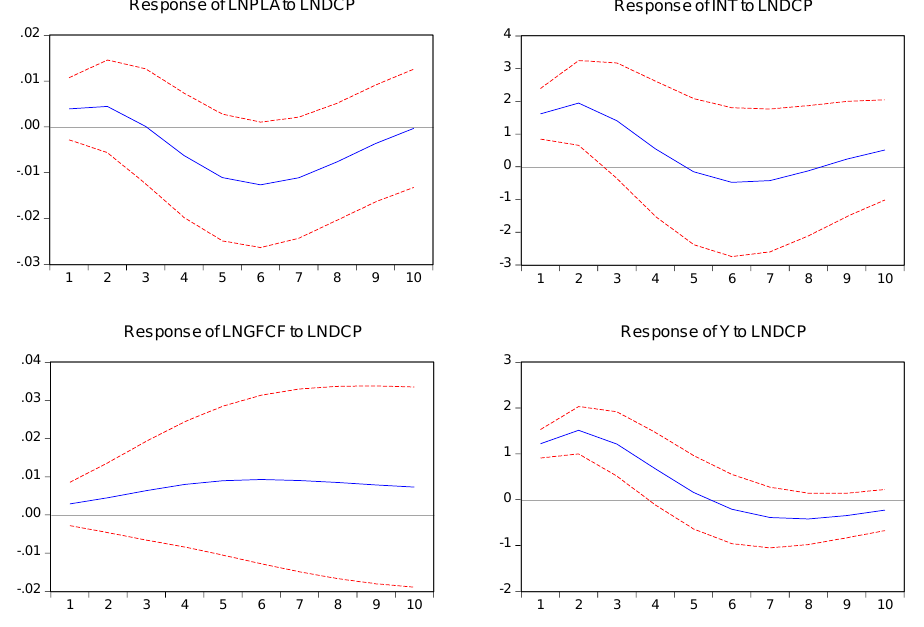
FIGURE 3: Impulse responses to a domestic credit to the private sector shock PLA: Potential Liquidity Available, INT: Real Interest Rate, DCP: Domestic Credit to Private Sector, GFCF: Gross Fixed Capital Formation, Y: GDP growth Impulse responses of a real output growth shock are presented in FIGURE 4. Potential liquidity available increases instantaneously following the output growth shock, probably to accommodate the increase in economic activity arising from the shock. The increase in potential liquidity, however, is marginally significant and it becomes clearly insignificant by the beginning of the second quarter. Interest rates respond to the shock by increasing initially, peaking at about 2.5% above the baseline after two quarters before taking a downturn and reverting to equilibrium. Domestic credit to the private sector also records an immediate increase following the shock, peaking after about two quarters. The instantaneous rise in domestic credit and interest rates in the first period is a direct consequence of the real output growth shock. The higher output growth in the first period requires an increase in investment and hence financial resources, consequently putting upward pressure on domestic credit to the private sector and interest